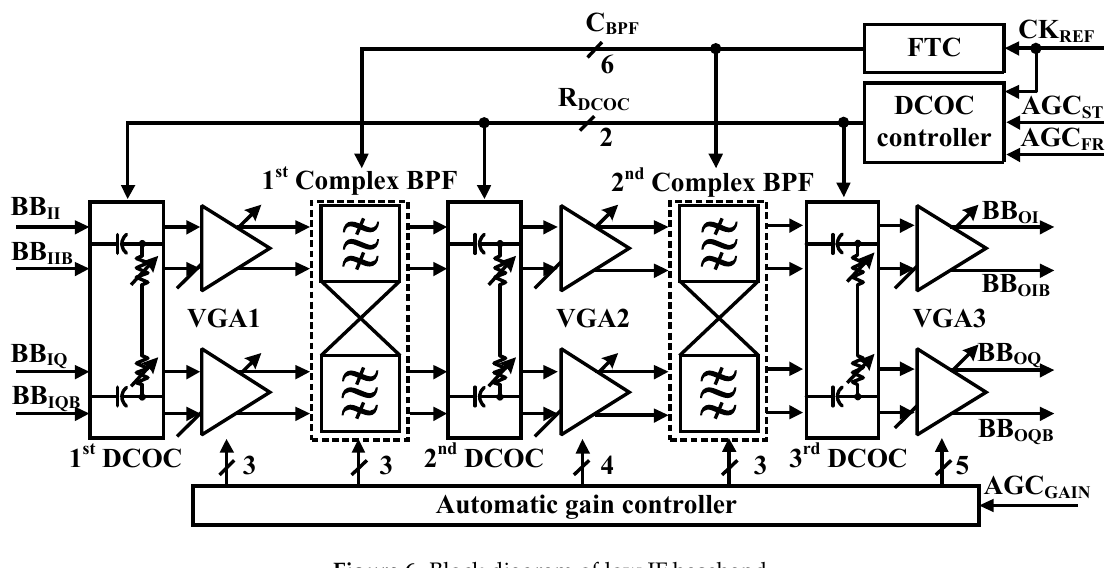
Figure 6. Block diagram of low IF baseband.